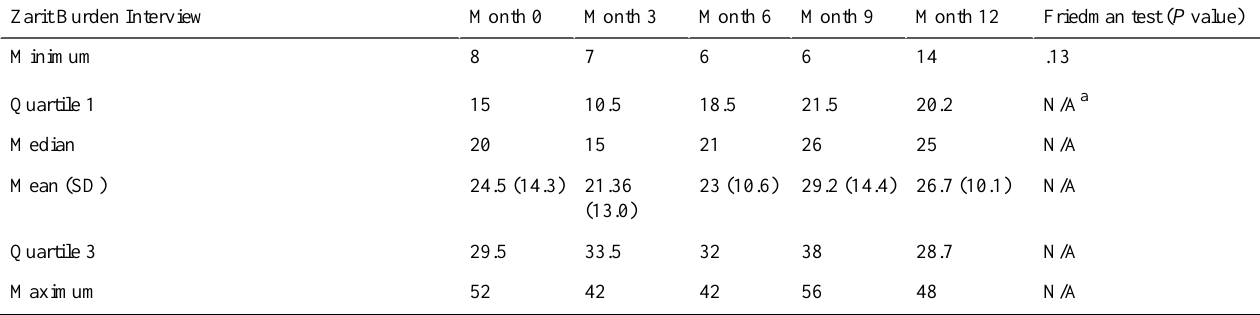
Table 17. Informal caregivers’Zarit Burden Interview score during the year progression.